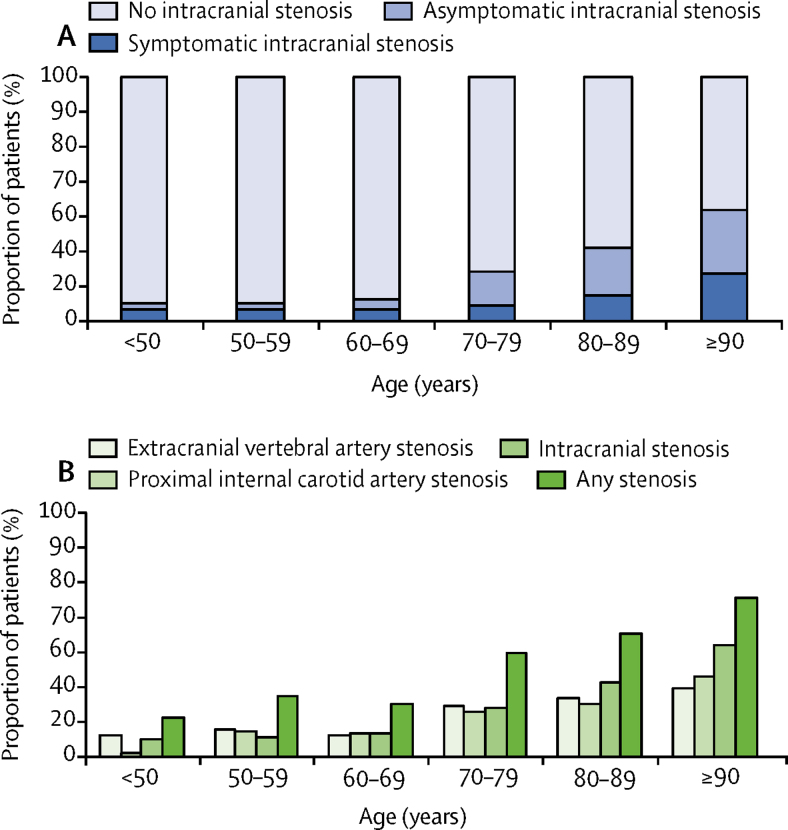
Age-specific prevalence of extracranial and intracranial stenosis(A) 50–99% symptomatic, asymptomatic, and no intracranial stenosis. (B) Proximal extracranial internal carotid artery stenosis, extracranial vertebral artery stenosis, 50–99% intracranial stenosis, and any stenosis (extracranial or intracranial).